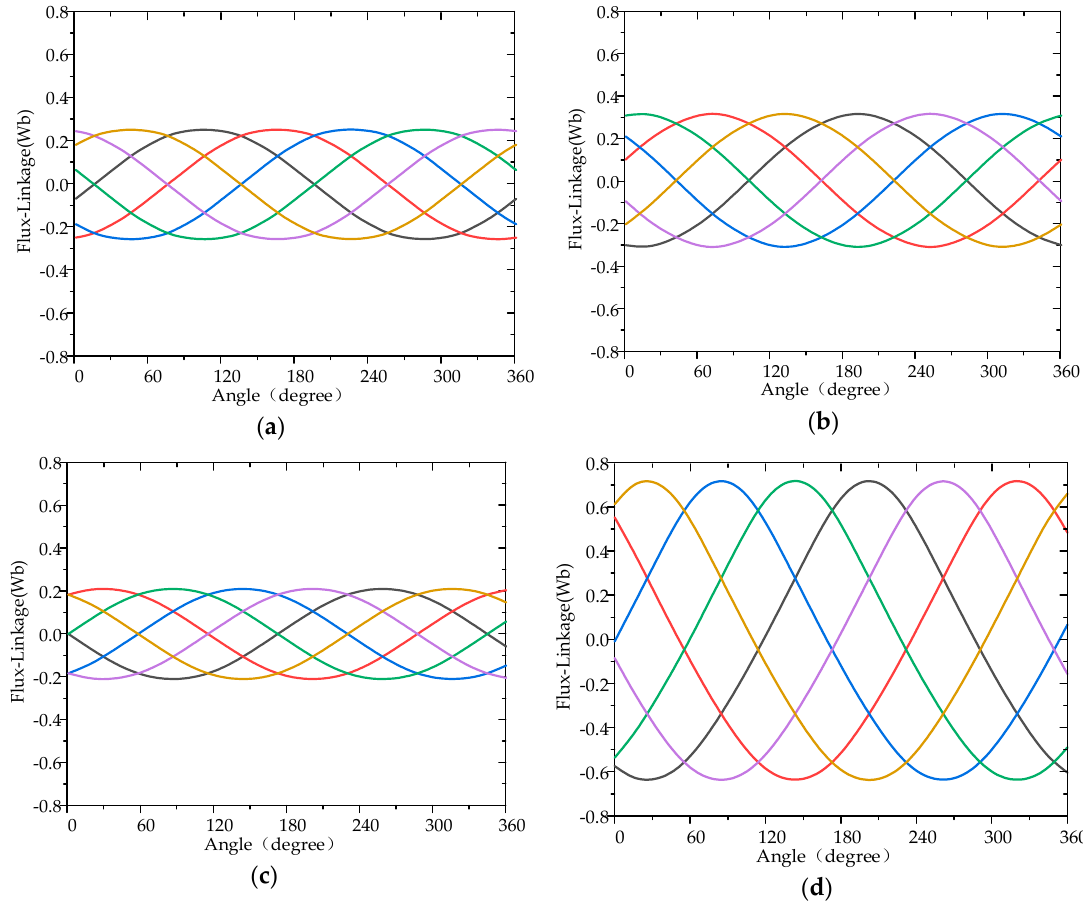
Figure 5. No-load flux-linkage of proposed six-phase outer-rotor PM machines: ( a ) IPM type; ( b ) SPM type; ( c ) PMFS type; ( d ) PMV type.